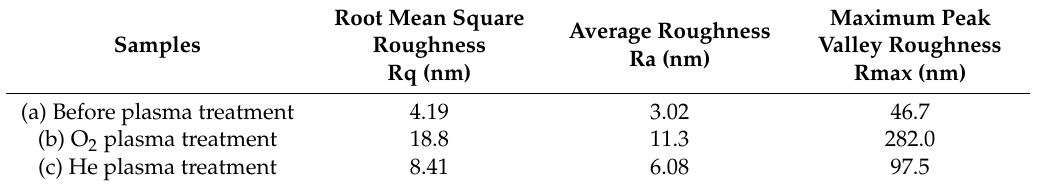
Figure 5. AFM images of polyester fiber surface ( a ) before and after ( b ) oxygen and ( c ) helium plasma treatments. Table 1. Roughness of the fiber surface before and after plasma treatments.